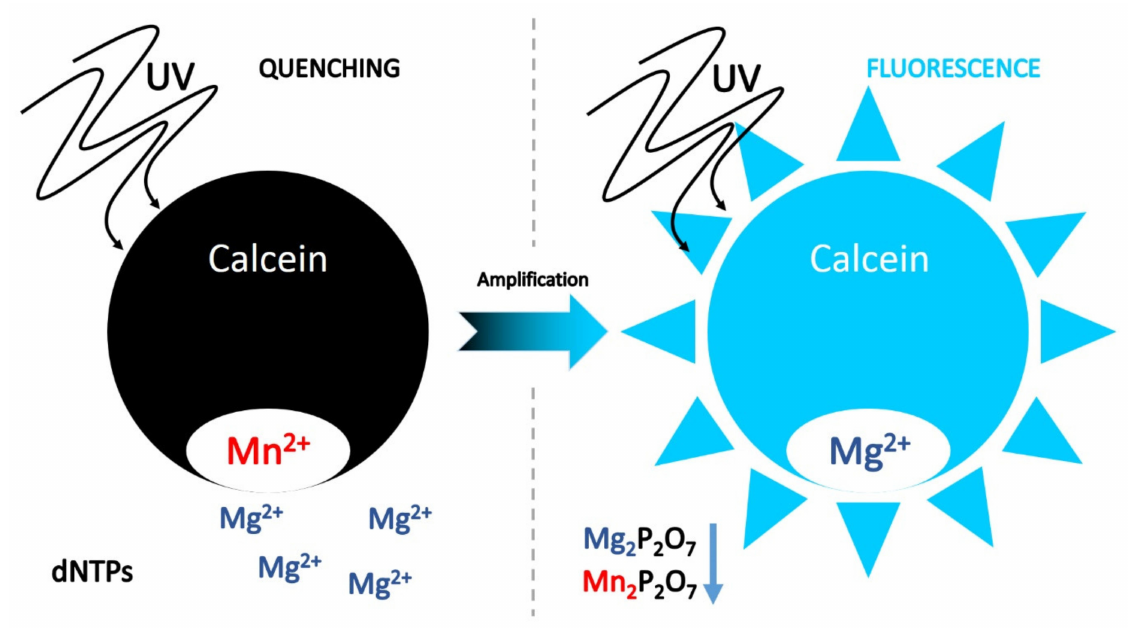
Figure 4. Detection using calcein as a fluorescent metal indicator. In the DNA amplification process, pyrophosphate ions are produced as a by-product from the reaction substrate deoxyribonucleotide triphosphates (dNTPs). In the presence of target DNA, during the LAMP reaction, newly generated pyrophosphate ion (P 2 O 74 − ) deprives calcein of manganous ion, which combines with residual magnesium ion (Mg 2 + ), producing greater